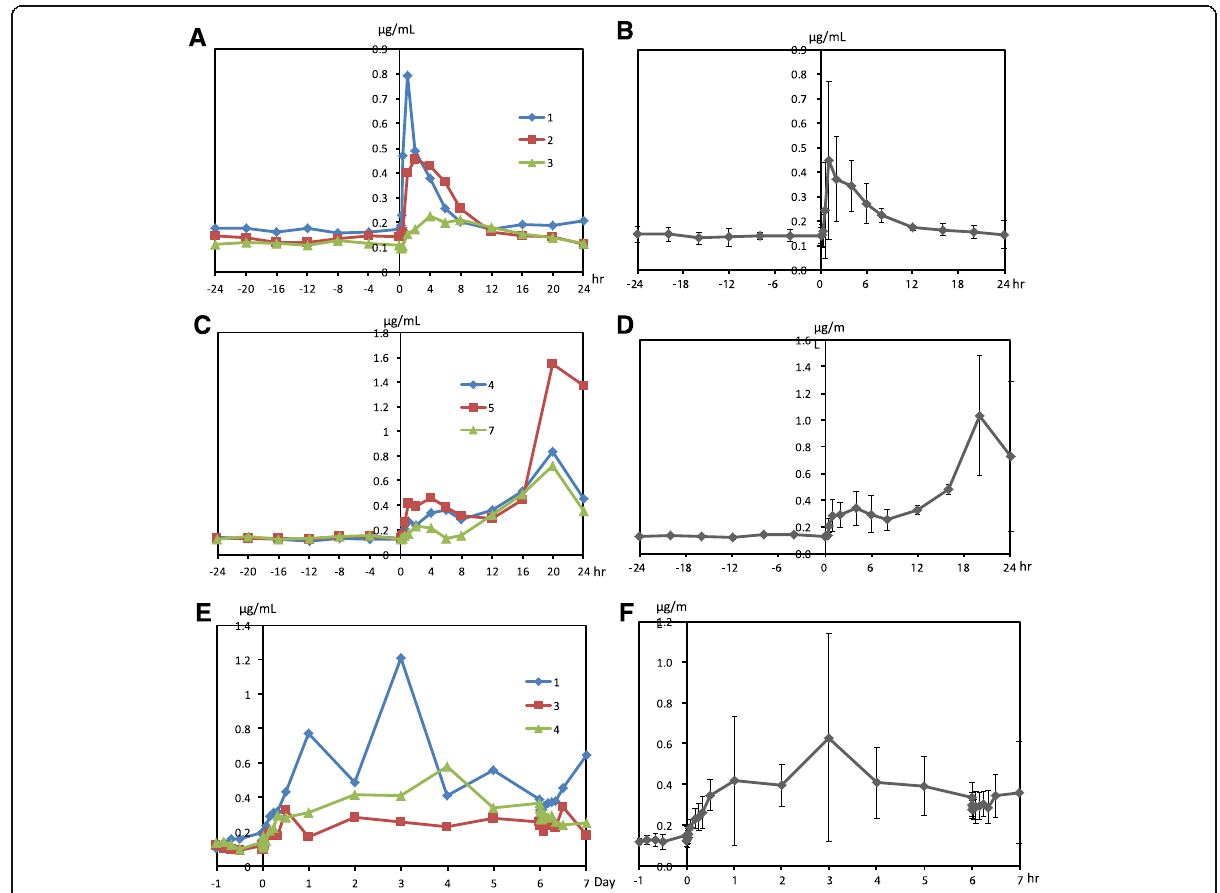
Fig. 5 Changes in serum free aceneuramic acid concentrations measurement (Trial-2). In Trial-2, serum free aceneuramic acid not bound to protein or lipid was measured, focusing on concentration increase due to investigational drug administration. Tough physiologically existing free aceneuramic acid is also measured, the concentration after administration clearly increased in each case. a . Single administration for each individual subject. b . Single administration on average. Mean changes ± standard deviation, n = 3 for each group. c . Three-times-per-day administration for each individual subject. In three-times-per-day administration, the 2nd and 3rd administration is 8 and 14 h after the 1st administration. d . Three-times-per-day administration on average. Mean changes ± standard deviation, n = 3 for each group. e . Three times per day for 7-day administration for each individual subject. f . Three times per day for 7-day administration on average. Mean changes ± standard deviation, n = 3 for each group. In all cases of 7-day administration though individual variations were large, a clear increase in concentration was observed during administration and was maintained for 7 days. The peak of the trough value was different in each subject but was